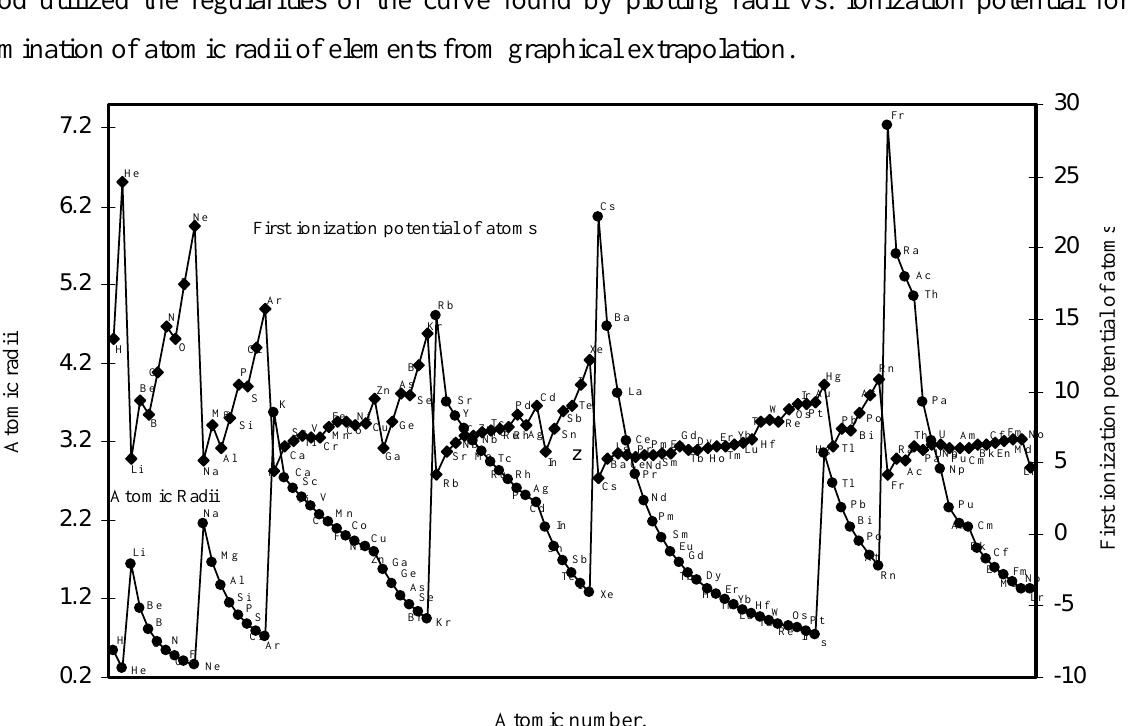
Figure 10. Plot of atomic radii and first ionization potential of atoms as a function of atomic